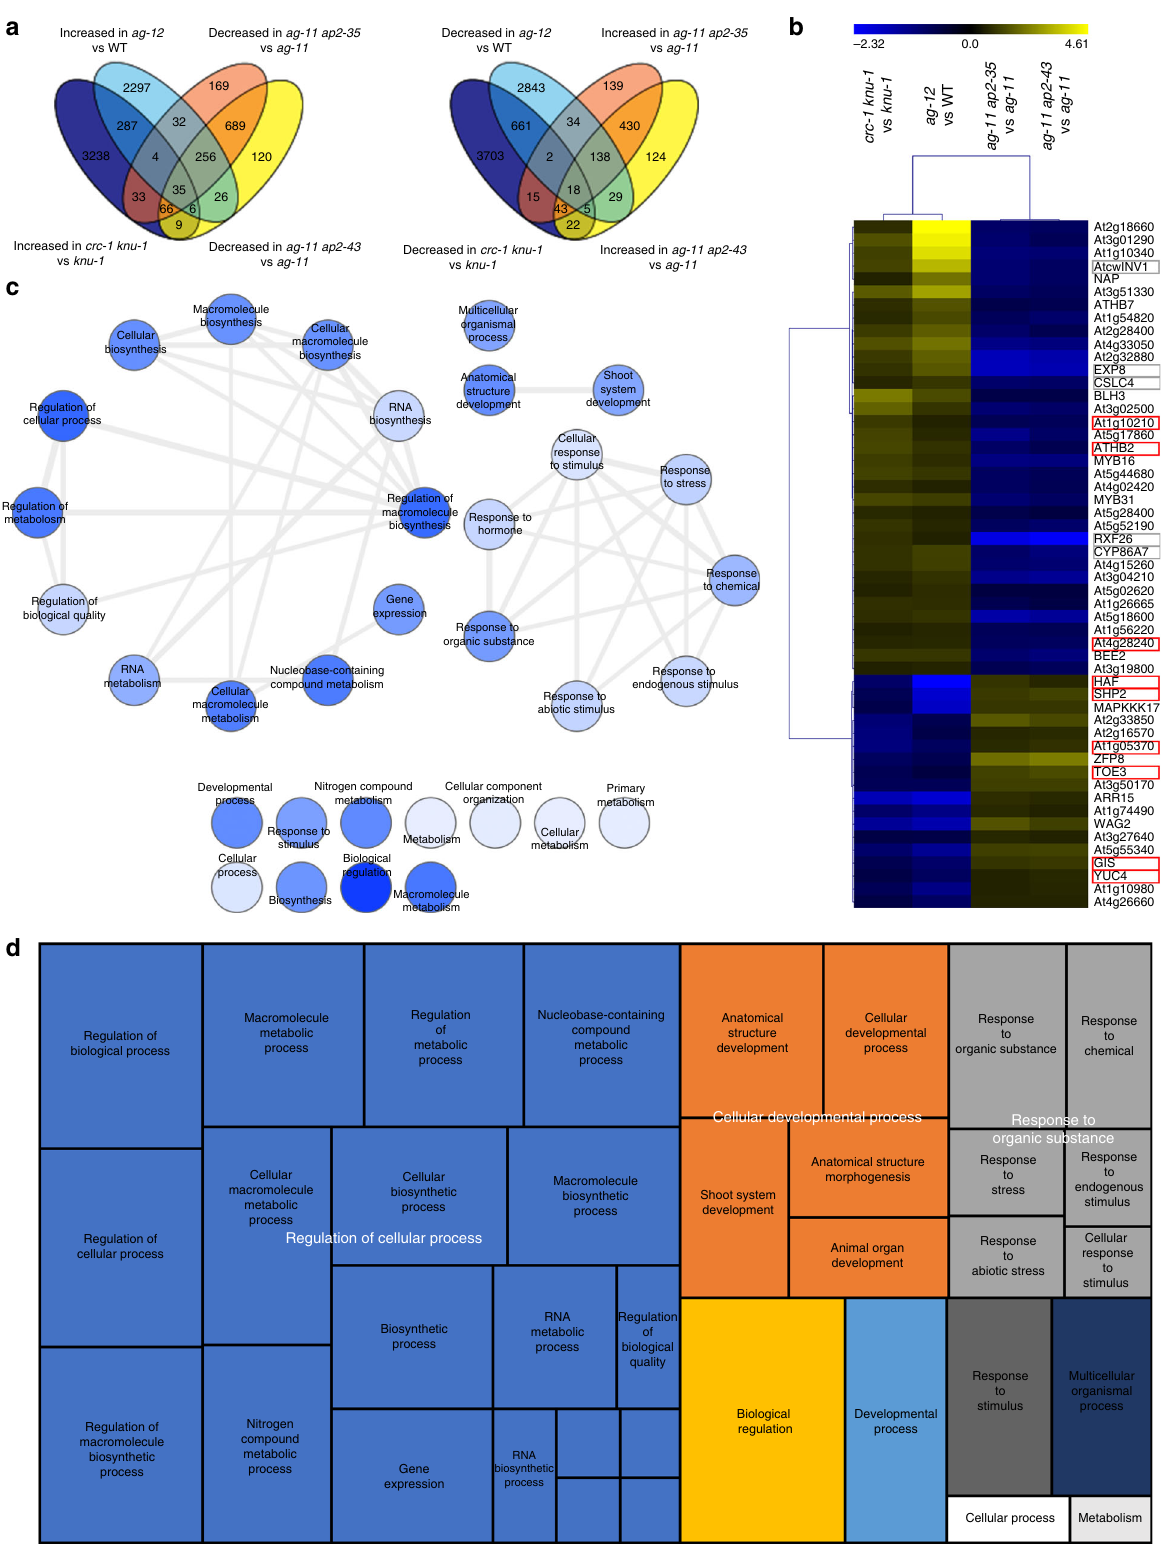
Fig. 1 Identi fi cation of downstream targets of AG and CRC during fl ower development. a Venn diagrams showing the overlap between genes with increased/decreased expression in crc-1 knu-1 vs knu-1 and ag-12 vs WT, and genes with decreased/increased expression in ag-11 ap2-35 vs ag-11 and ag-11 ap2-43 vs ag-11 . b Hierarchical clustering of 53 genes downstream of AG and CRC. The heat map displays the log 2 fold change of differentially expressed genes based on public datasets. Red and gray boxes highlight AG direct targets and cell wall regulators, respectively. c Interactive graph view generated by REVIGO. Dark and light colors indicate lower and higher p -values, respectively. Circle sizes indicate the frequency of the GO term in the underlying